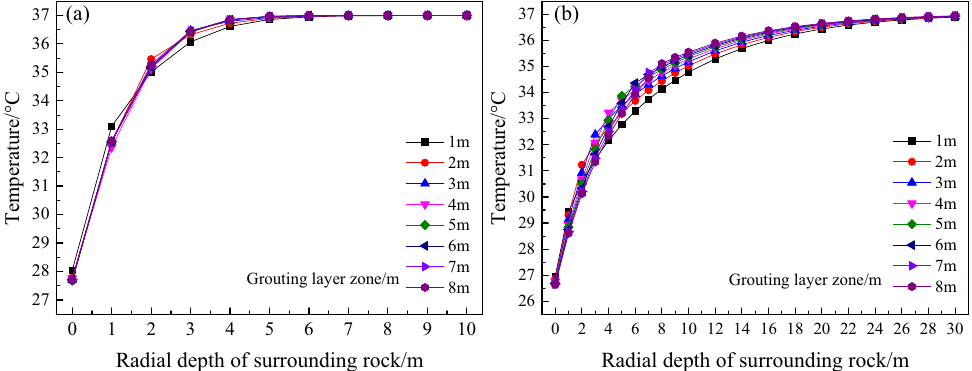
Figure 13: Influence of grouting layer zone on surrounding rock temperature field: ( a ) 30 days; ( b ) 1,095